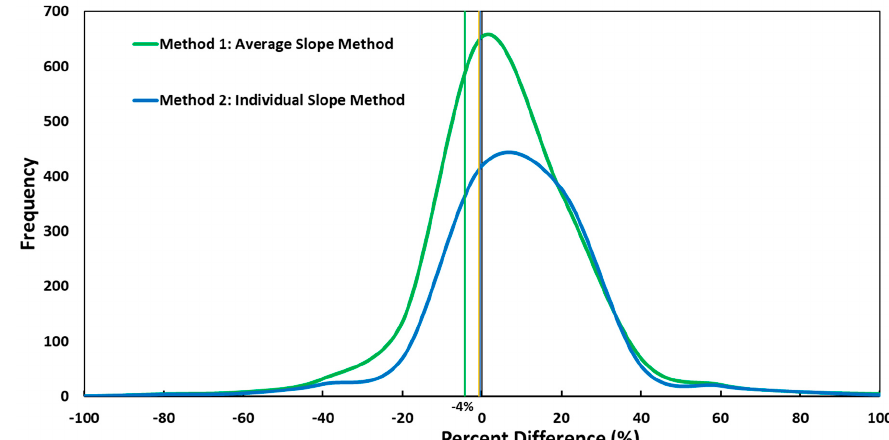
Figure 3. Frequency of percent differences to compare different calibration and selection methods for 1-min averages.